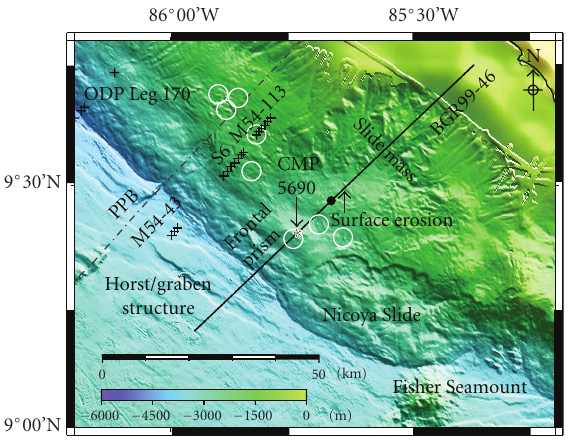
Figure 2: Bathymetry close-up [64] of the area around line BGR99- 46, the ODP Leg 170, the heat flow measurement locations S6 [18] and M54-43/113 [16], the Nicoya Slide, the Fisher Seamount, white encircled mud mounds [60], CMP 5690 (Figure 4), and the projected CMP 1410 (black dot) of profile SO81-09, where Pecher et al. [9] have applied a full waveform inversion (discussed in the